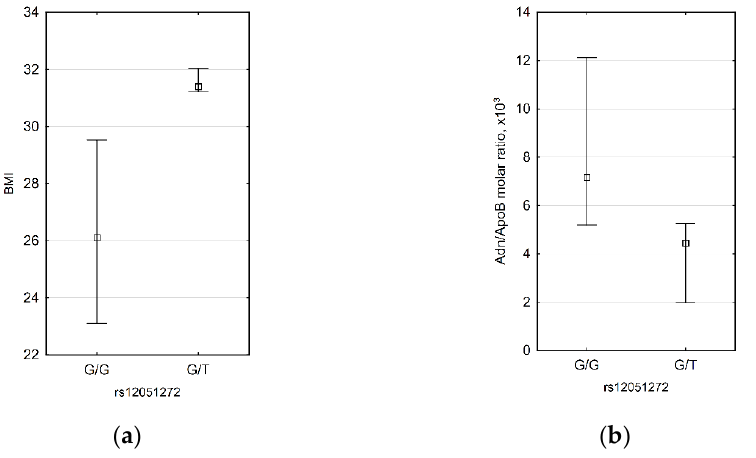
Figure 3. Significant differences between rs12051272 T allele carriers and non-carriers: subjects with G/T genotype have higher BMI ( a ) and lower HMW adiponectin/ApoB molar ratio ( b ). n = 35 for both diagrams.